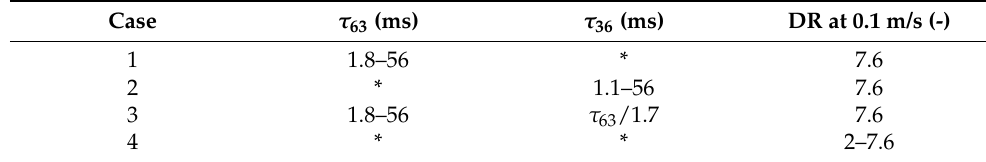
Table 2. The variables for sensitivity analysis.